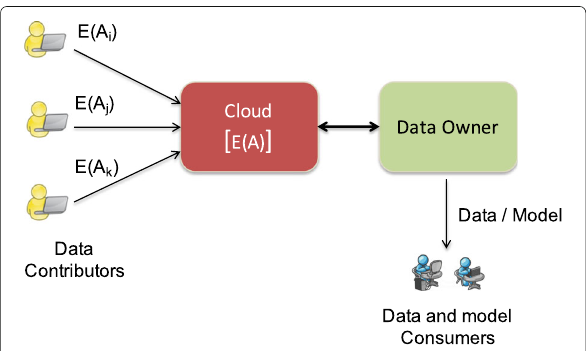
Fig. 1 A data owner outsourcing to an untrusted cloud provider for learning a model. The data contributors directly submit their encrypted data to the cloud. The cloud carries out the major expensive computations over the encrypted data and data owner can assist with some lightweight